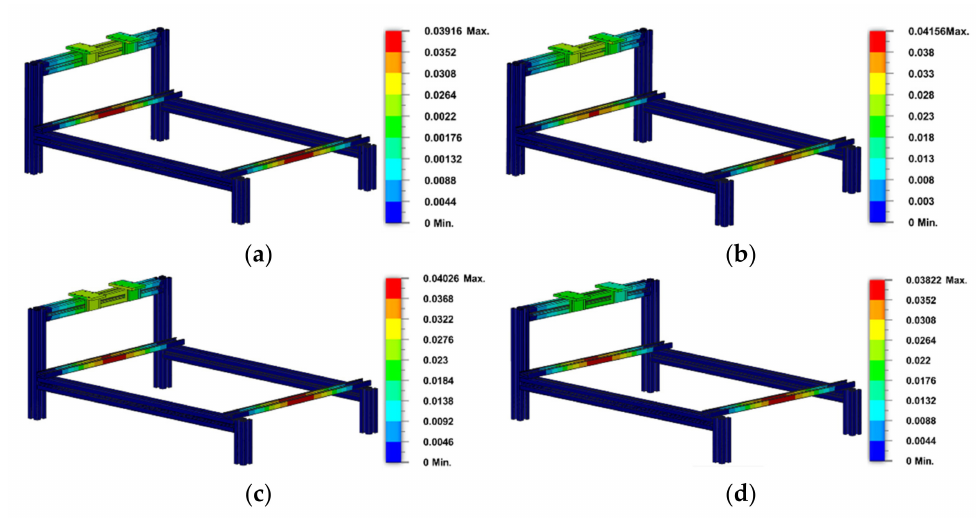
Figure 11. Contour of Displacement on Cantilever Crane: ( a ) Standard Type; ( b ) Lightweight Type; ( c ) Economy Type; ( d ) High-Rigidity Type.